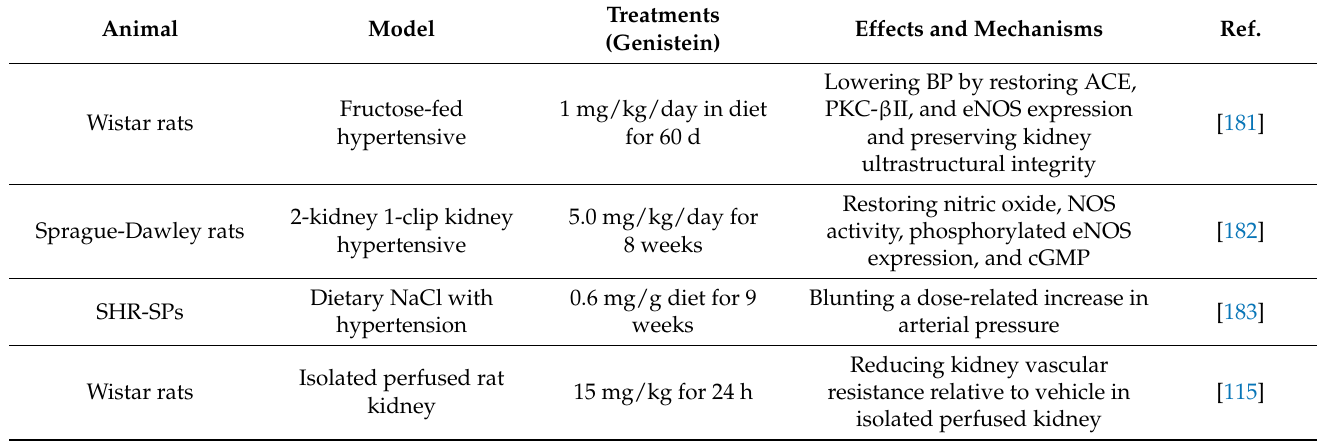
Table 5. The effects of genistein attenuating hypertensive kidney